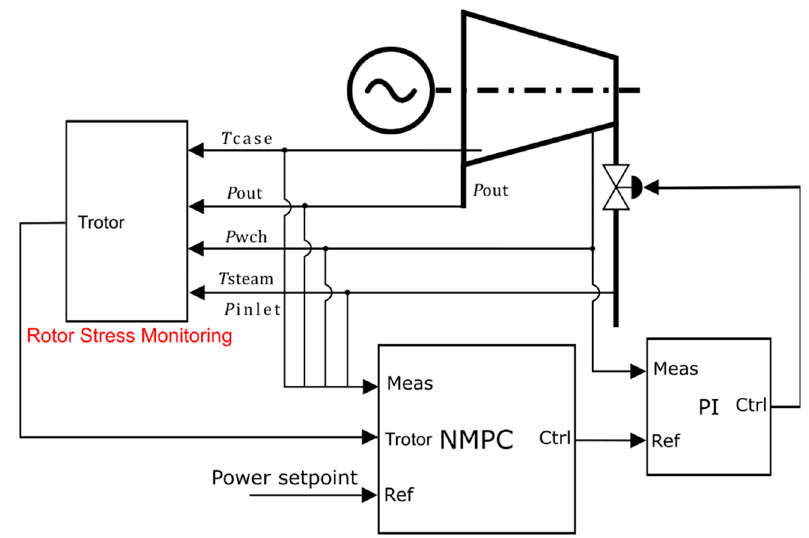
Figure 7. Architecture of the startup control system.